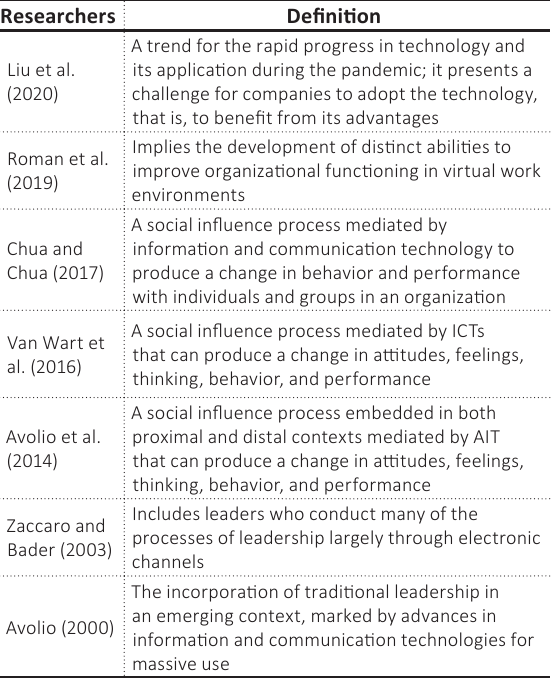
Table 1. Definitions of virtual